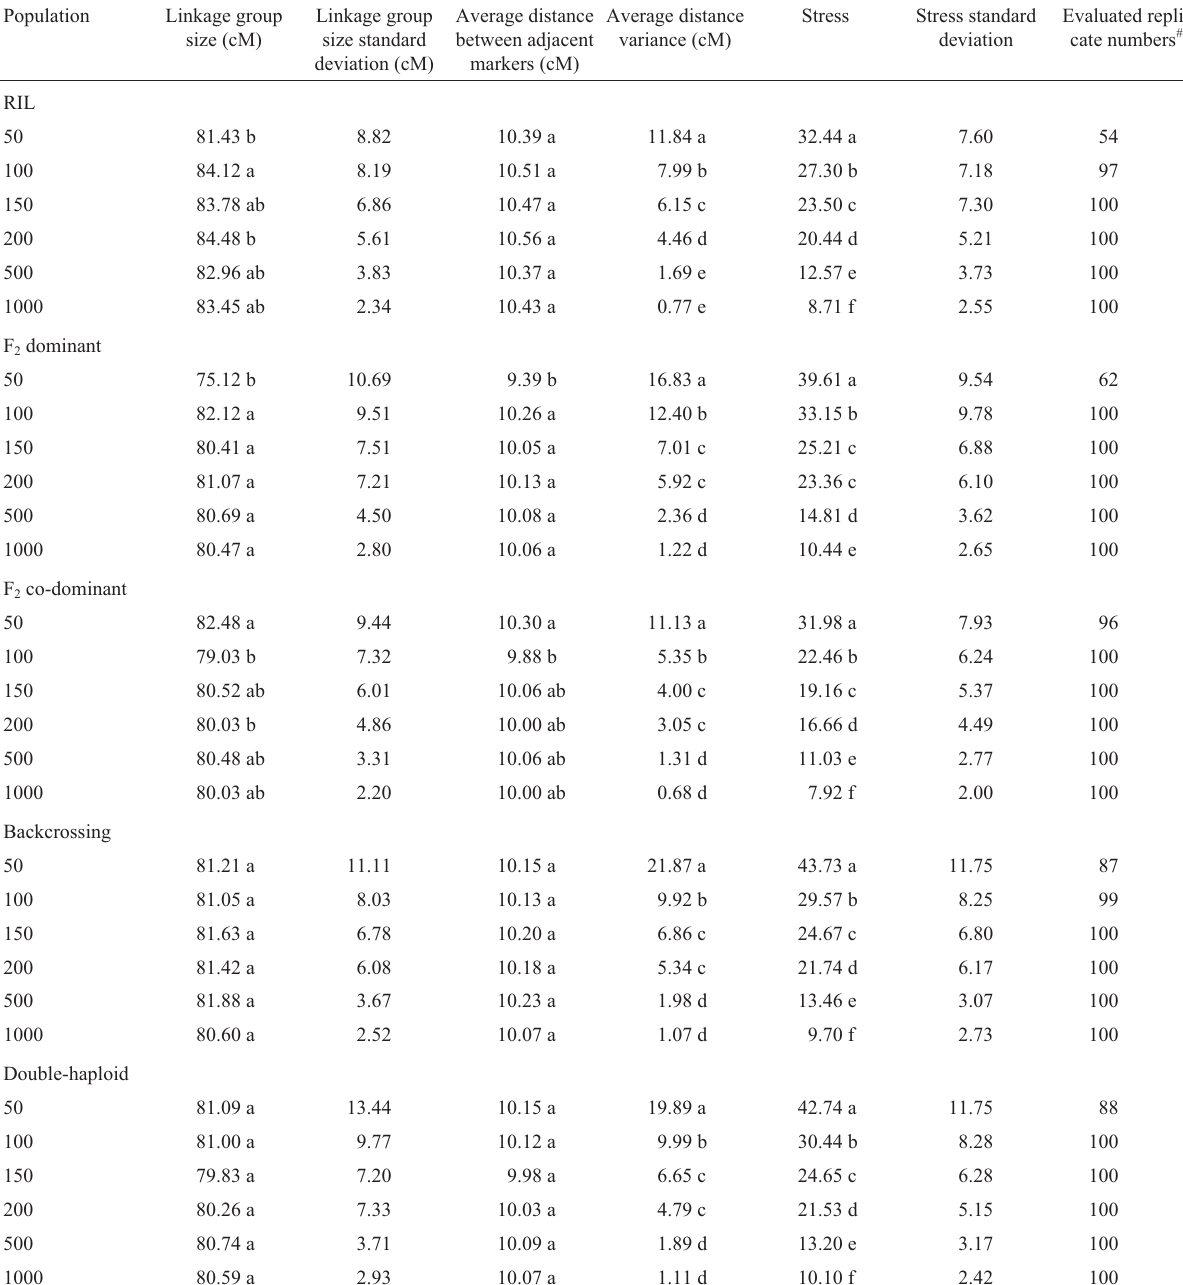
Table 2 - Average linkage group size, distance between adjacent linkage group markers and stress in different population types and